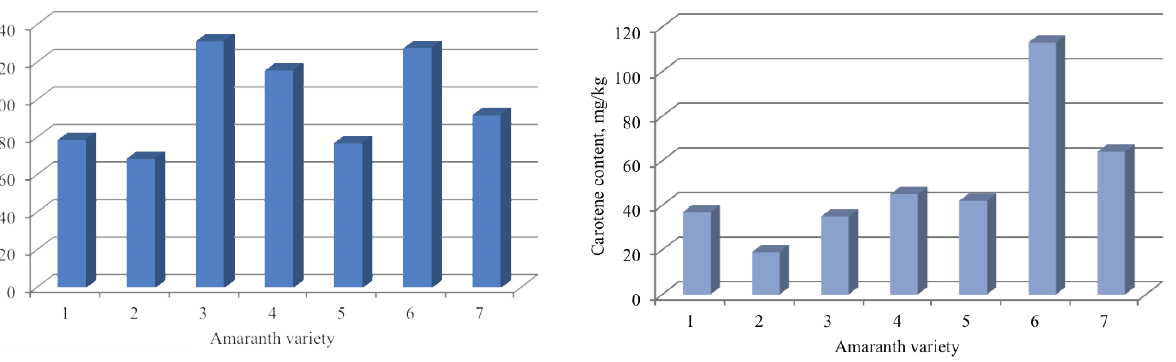
Figure 2 Digestible protein content in amaranth leaves by variety: 1 – Voronezh-36, 2 – Imperator, 3 – Rubin, 4 – Universal, 5 – Gigant, 6 – Dobrynya, 7 – Valentina Table 4 Mineral substances in amaranth leaves Amaranth variety